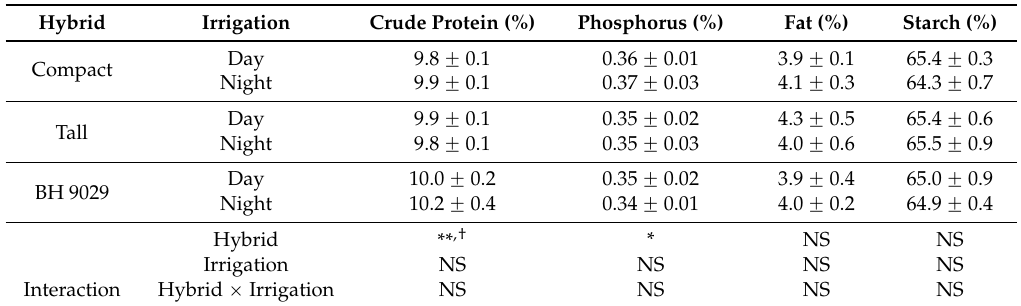
Table 3. Grain chemical composition in three hybrids of corn comparing drip irrigation delivery in day-time vs. night-time ( n =